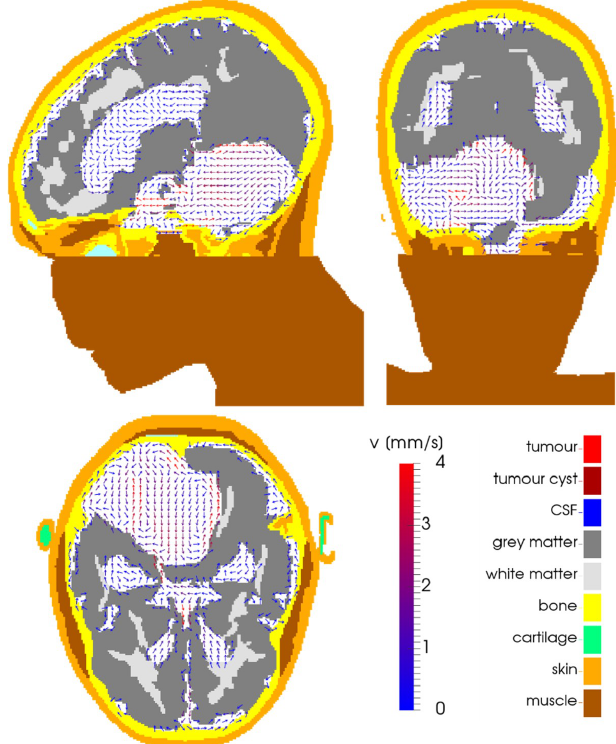
Figure 10. For the post-operative case, the arrows show the direction of the CSF flow in the depicted planes, while the colour of the arrows indicates the magnitude of the flow velocity, as indicated by the colour bar. The solid tissues are colour-coded according to tissue type, using the same colour map as Fig. 1b. The panels show planes through the tumour’s centre of gravity in the left-right (top-left), anterior-posterior (top-right), and cranial-caudal (bottom-left) directions.